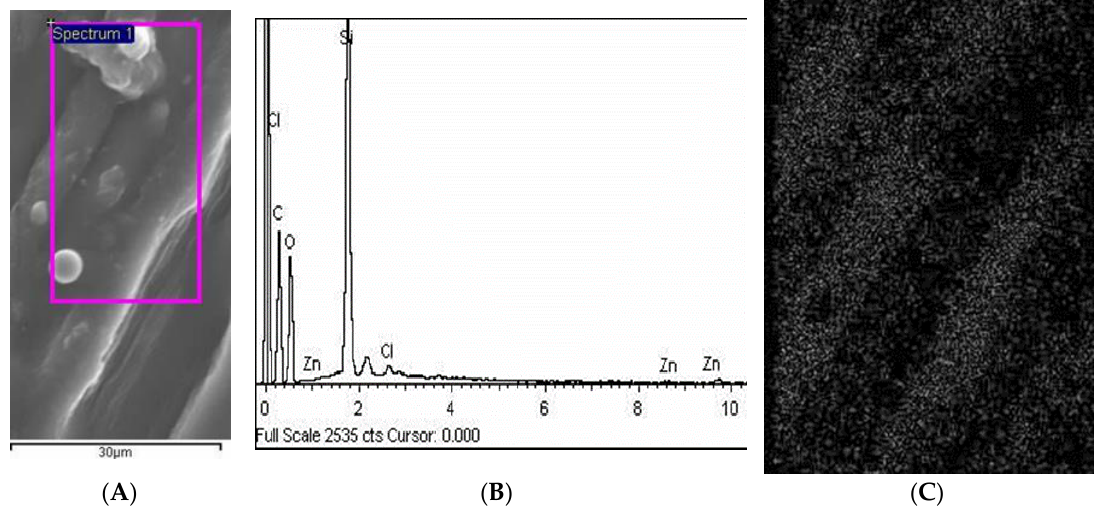
Figure 3. ( A ) SEM microphotograph of ZnO nanoparticle and homogenous coating layer on cellulose materials with specified area used for EDX investigation, The purple square is the area that was scanned for mapping (C); ( B ) Results of the SEM-EDX investigation with the proof that the cellulose material was successfully modified with the ZnO coating, ( C ) SEM-EDX mapping was additionally performed on a specified area of the cellulose material in order to detect ZnO nanoparticles (gray dots on